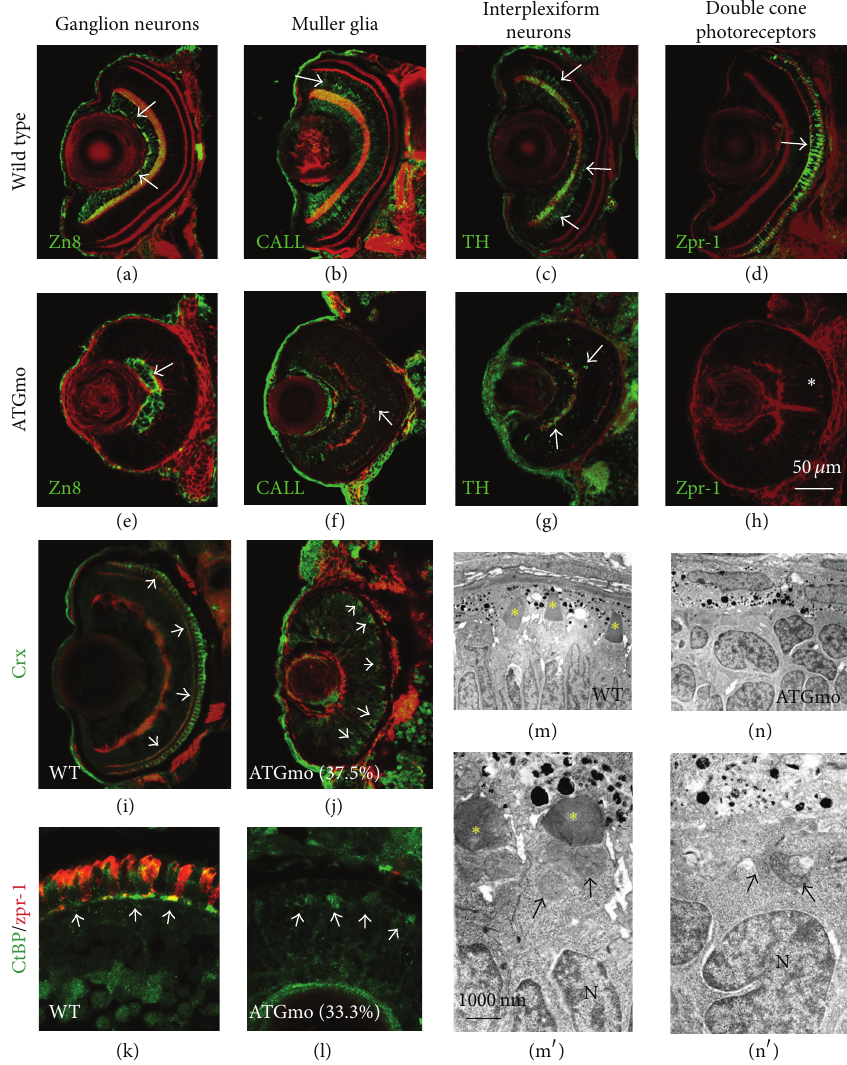
Figure 3: Disruption of zBves affected the dysregulated patterns in the retina. The frozen sections and immunofluorescence staining with different marker antibodies—zn8 for ganglion cells (a), (e), anti-CAII for M¨uller glia (b), (f), anti-TH for interplexiform neurons (c), (g), and zpr-1 for photoreceptors (d), (h) were performed in eyes of 96hpf wild-type and zBves MO-injected embryos. Immunofluorescence staining with Crx (i), (j) antibody in the frozen sections was performed in 72 hpf embryos. 37.5% (6/16) of mutant retina showed Crx protein. The ultrastructures of the retina in wild-type (m), (m 󸀠 ) and zBves MO-injected embryos (n), (n 󸀠 ) were analyzed by TEM. Double staining with CtBP and zpr-1 was adopted in frozen crytosections (k), (l). 33.3% (4/12) of mutant retina showed CtBP protein without zpr-1 expression (l). Asterisks indicate the outer segment. Black arrows indicate the inner segment. N, nucleus; S, Scale bar in immunostaining photographs, 50 𝜇 m. Scale bar in TEM picture, 1000